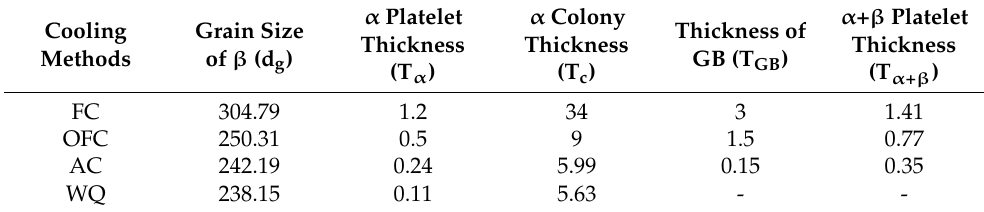
Table 1. Microstructure parameters of TC21 alloy at different cooling methods ( µ